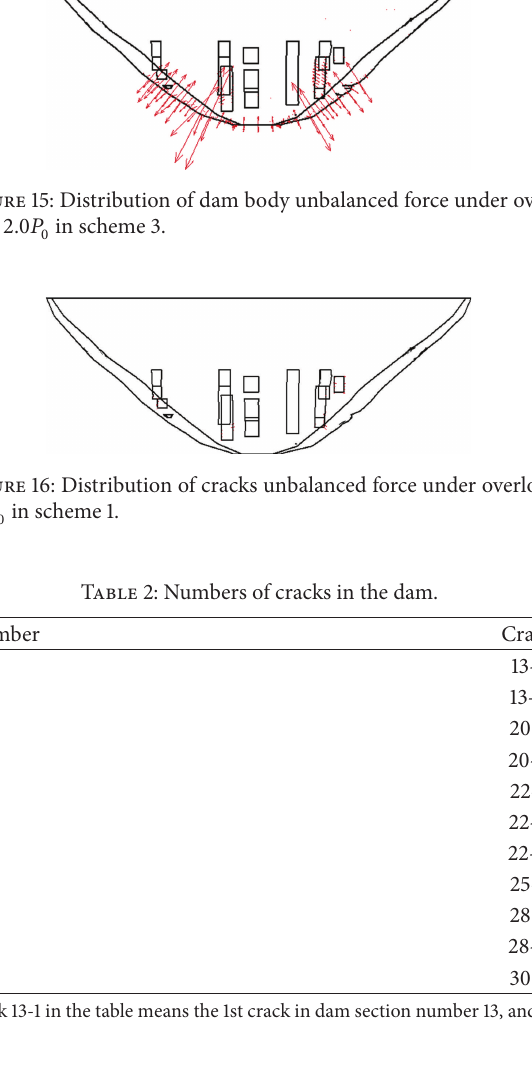
Table 3: Material